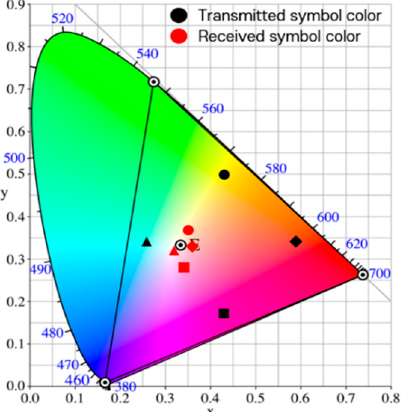
Figure 7. Distortion of the symbol transmission/reception process as observed in the real world.